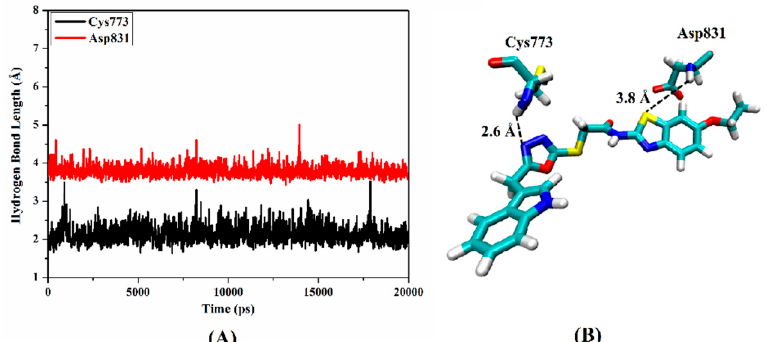
Figure 3. ( A ) Hydrogen bond lengths (in A ) between compound 2e and the key amino residues (Cys773 and Asp831) of EGFR over 20 ns MD simulation. ( B ) Three-dimensional representation of the average structure of compound 2e inside the active site of EGFR during 20 ns of MD simulation.